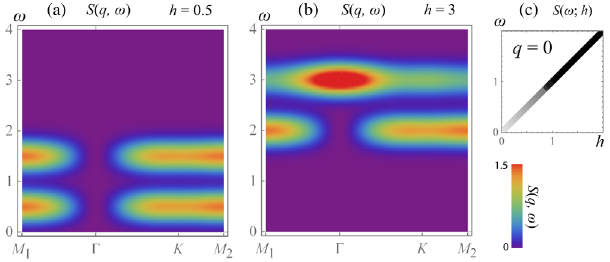
FIG. 8. Spin dynamics in a magnetic field. The dynamical structure factor for isolated singlets, randomly distributed as in Fig. 5, in an applied magnetic field [Eq. (29)]. (a),(b) Transverse spin fluctuations S ð q; w Þ at fields h ¼ 0 . 5 (a) and h ¼ 3 (b), with h ≡ g μ H=J 0 . Dirac δ functions are plotted as σ ¼ 0 . 2 Gaus- B sians. (a) For fields h < 1 smaller than the singlet-triplet splitting, low-intensity features are visible at the Γ point ( q ¼ 0 ): fixing ≡ 1 (cid:2) h (here ω frequency at ω ¼ ω ¼ 0 . 5 , 1.5) and taking (cid:2) (cid:2) q → 0 shows the intensity decreasing . The spread of intensity in q and ω away from these points can manifest as “ constriction points ” of minimum intensity. (b) For fields h > 1 that start to polarize a given singlet, a q ¼ 0 peak is observed at a frequency ω ≡ h , which scales linearly with field. Coupling the isolated 0 singlets will connect the ω ¼ h , h − 1 features into a magnon dispersion. (c) Given some broad distribution of energy splittings, e.g., as in Fig. 6, the structure factor at q ¼ 0 shows a single peak, at ω ¼ h , with an intensity that increases with h and saturates for h ⪆ 1 . This q ¼ 0 feature, as well as the q → 0 decrease in intensity approaching the constriction points, are observed in experiments